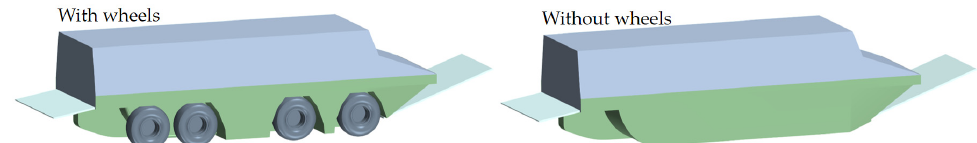
Figure 8. Geometry of the bare vehicle with and without wheels.